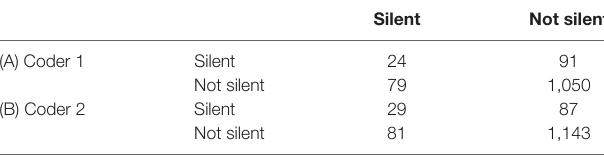
TaBle 4 | (A) Data for coder 1 and (B) data for coder 2.